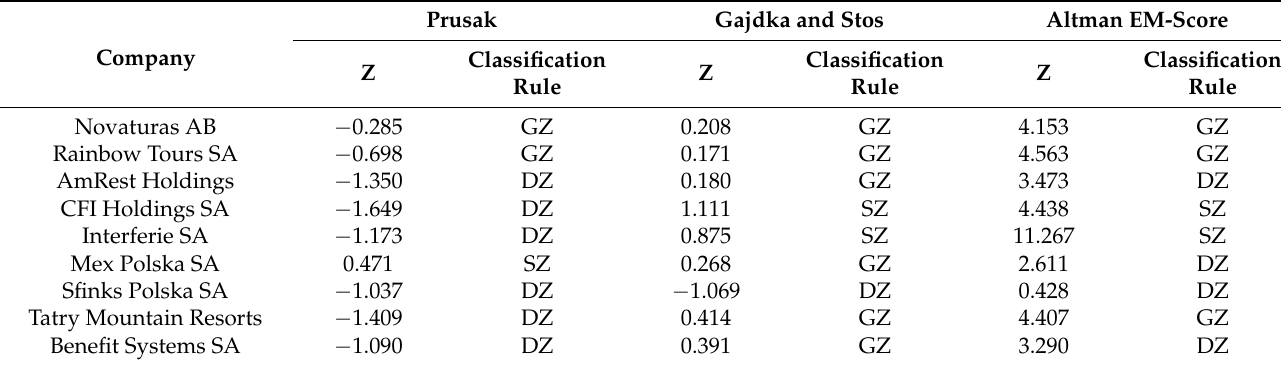
Table 1. The value of the discriminant functions in the first half of 2019.